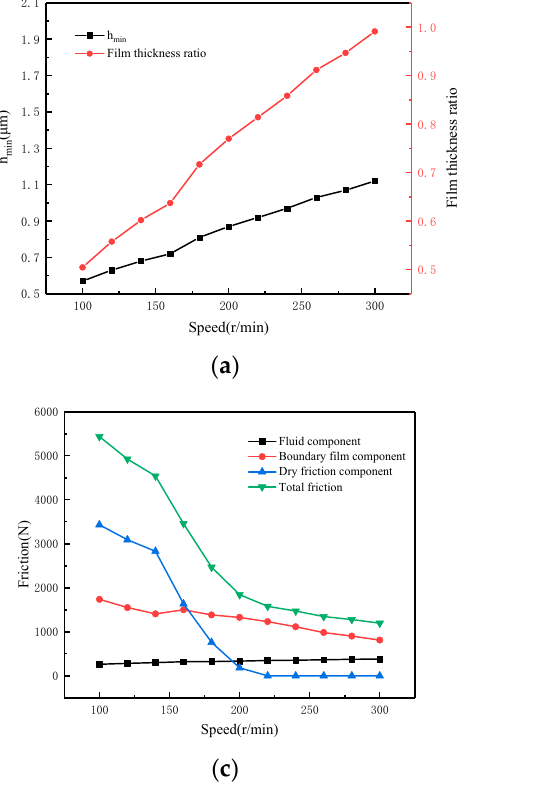
Figure 14. Influence of sliding speed on lubrication performance. ( a ) Calculated film thickness; ( b ) Calculated asperity contacts; ( c ) Calculated friction components; ( d ) Calculated friction coefficient. From the above analysis, low speed is not conducive to the formation of oil film and cannot ensure a good lubrication state. An appropriate increase in speed can avoid the breakdown of the boundary film and the direct contact of asperities, reducing friction to improve mechanical efficiency and lubrication